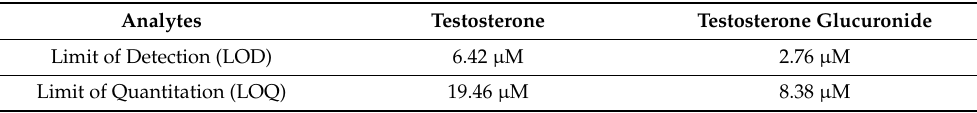
Table 6. LOD and LOQ for testosterone and testosterone glucuronide.